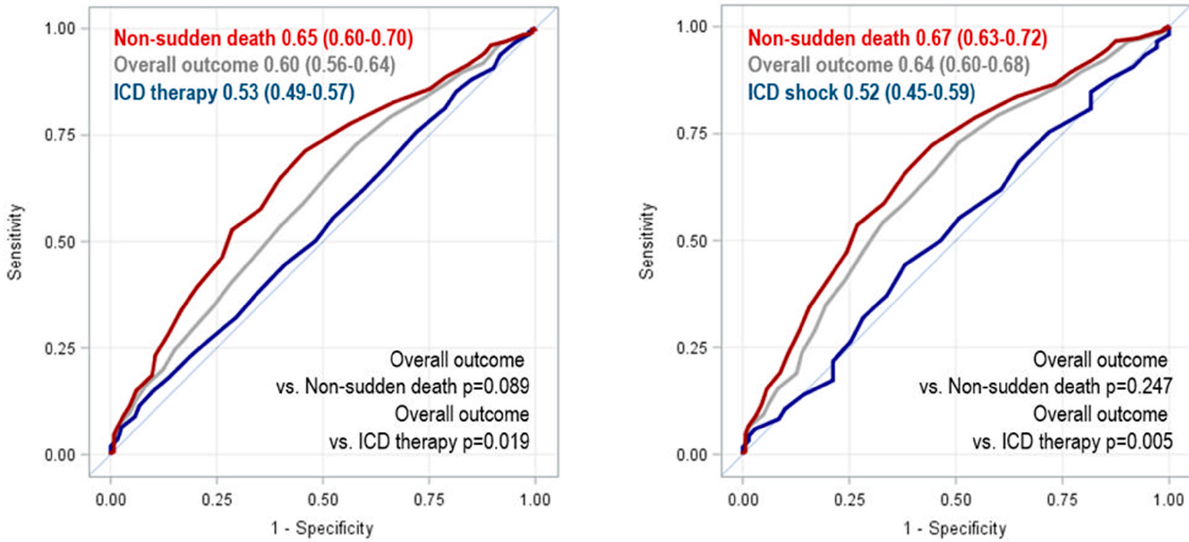
Figure 2. Accuracy of MAGGIC risk score in predicting ICD therapy or shock, non-sudden death, and the overall outcome.